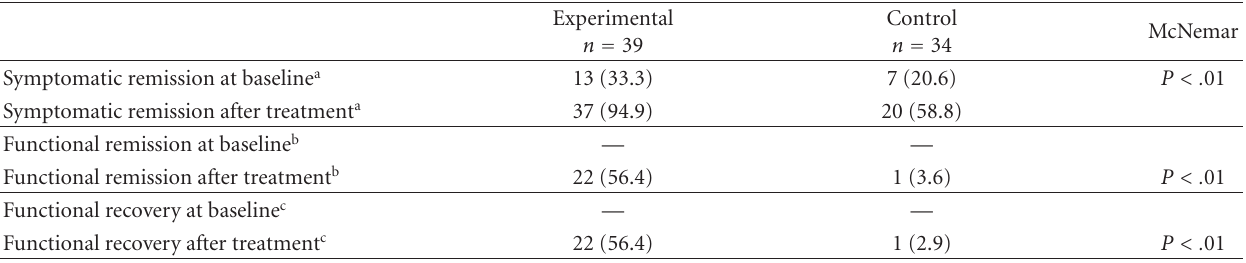
Table 3: Symptomatic remission, functional remission, and functional recovery at baseline and at the end of treatment.